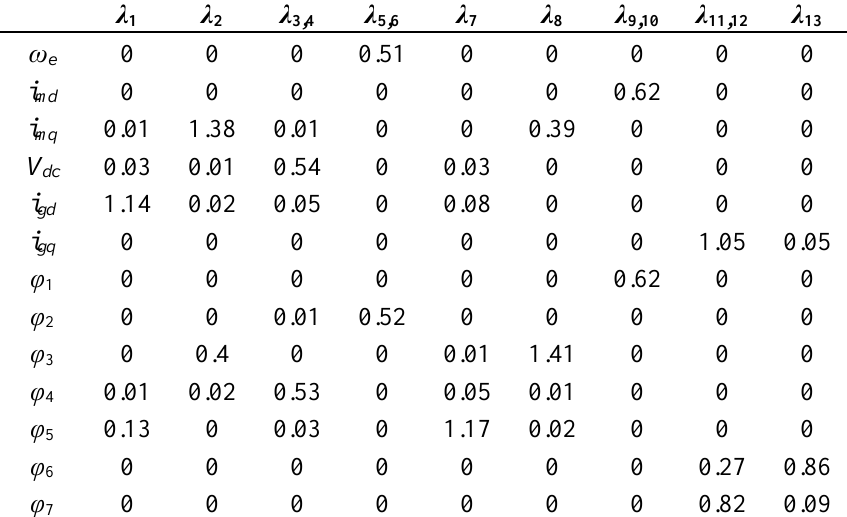
Table 3. Magnitudes of participation factors of state variables for Case